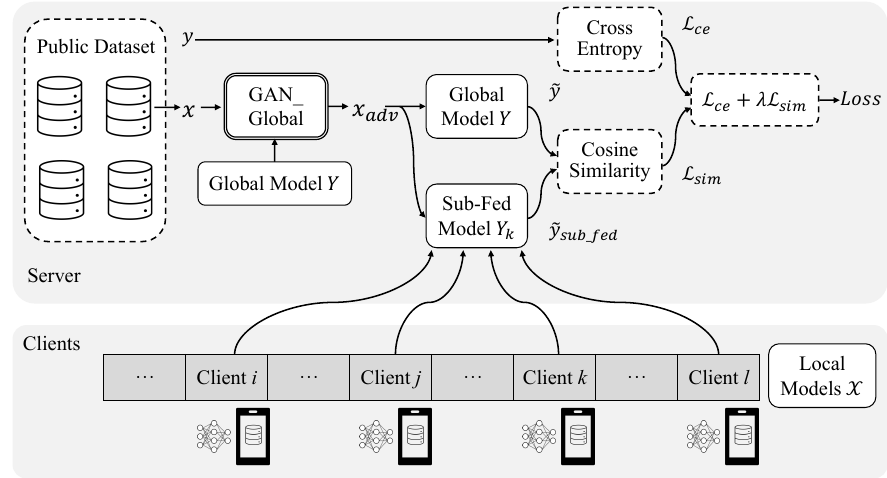
Figure 2. The server conducts differential adversarial training with the aid of a public dataset. The loss function consists of two parts: one is the cross entropy loss of the regular adversarial training, and the other is the cosine similarity loss between the global model and the sub-federated